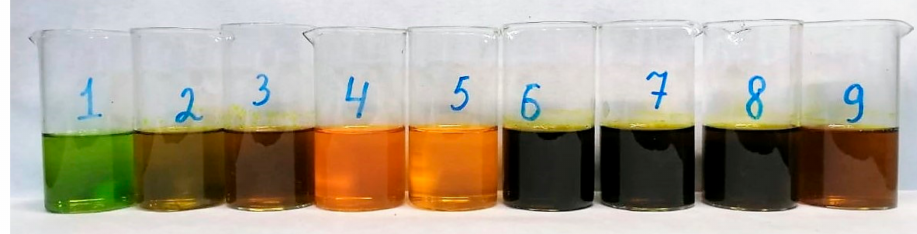
Figure 13. Aqueous phase from the corresponding chamber of the cascade.